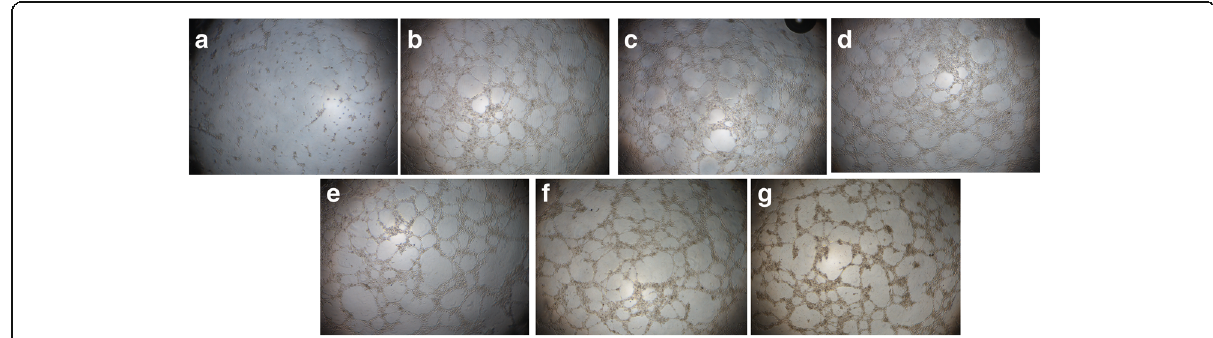
Fig. 6 Tube formation assay in HUVECs incubated with KFX and PC substance. The morphological changes of the cells treated with different concentrations of KFX and PC substance are observed and photographed using a digital microscope. a Blank control (untreated), b KFX (0.1 mg/mL), c